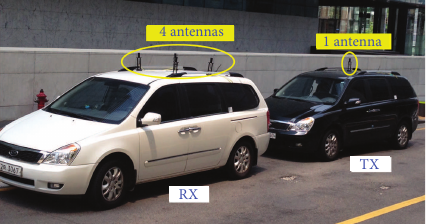
Figure 2: Equipment installation on vehicles where 1 omni-direc- tional antenna in TX and 4 omni-directional antennas (separated by 10 wavelengths) in RX are installed on the rooftop.